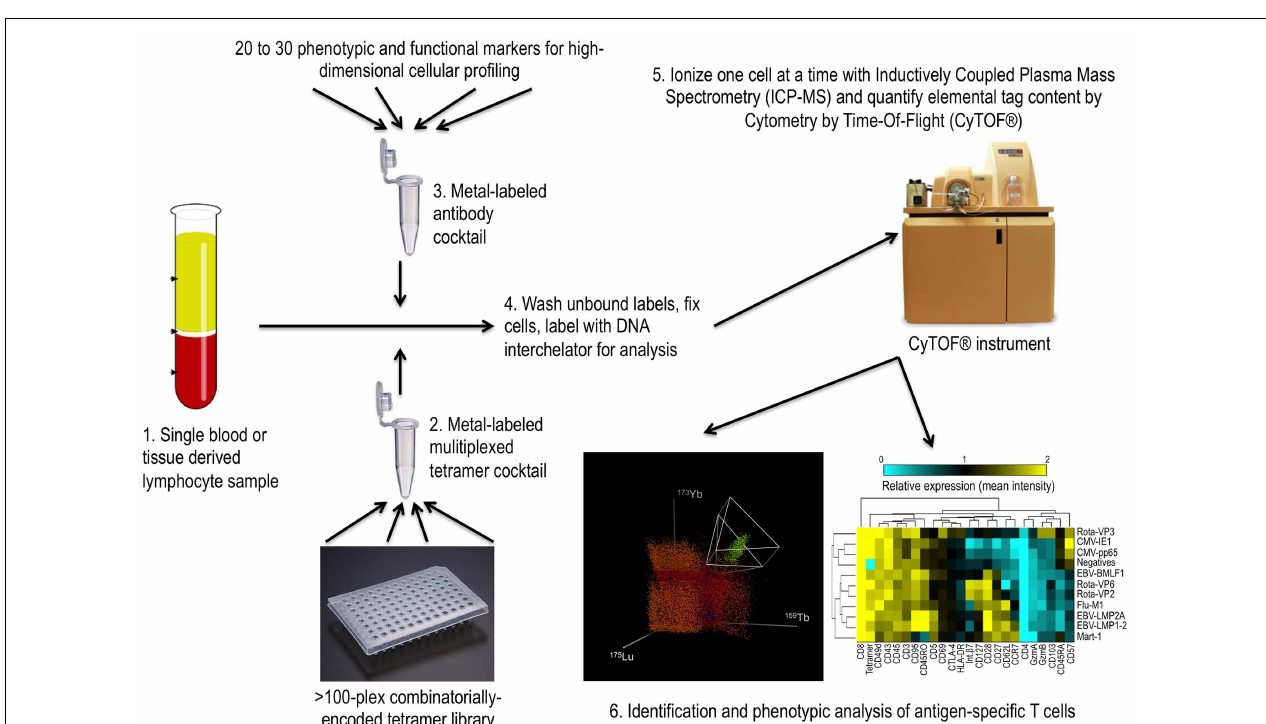
cells are fixed, stained with metal-labled DNA interchelator, washed, and resuspended in water. 5. As they are introduced to the CyTOF® mass cytometer, the cells are sprayed through a nebulizer and dried in argon before being ionized in plasma.Time-of-flight mass spectrometry is used to quantify each of the elemental tags on each cell. 6. Identities of antigen-specific cells are determined using multidimensional deconvolution algorithms and the phenotypic and functional characteristics of these cells can be compared through various analysis methods such as the clustergram